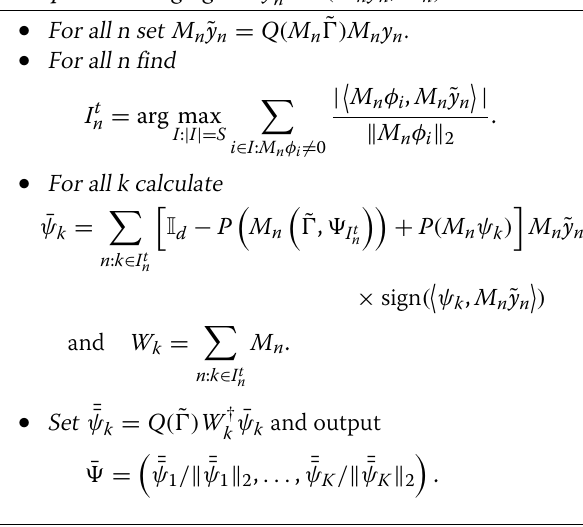
Algorithm 2 (ITKrM for corrupted data - one